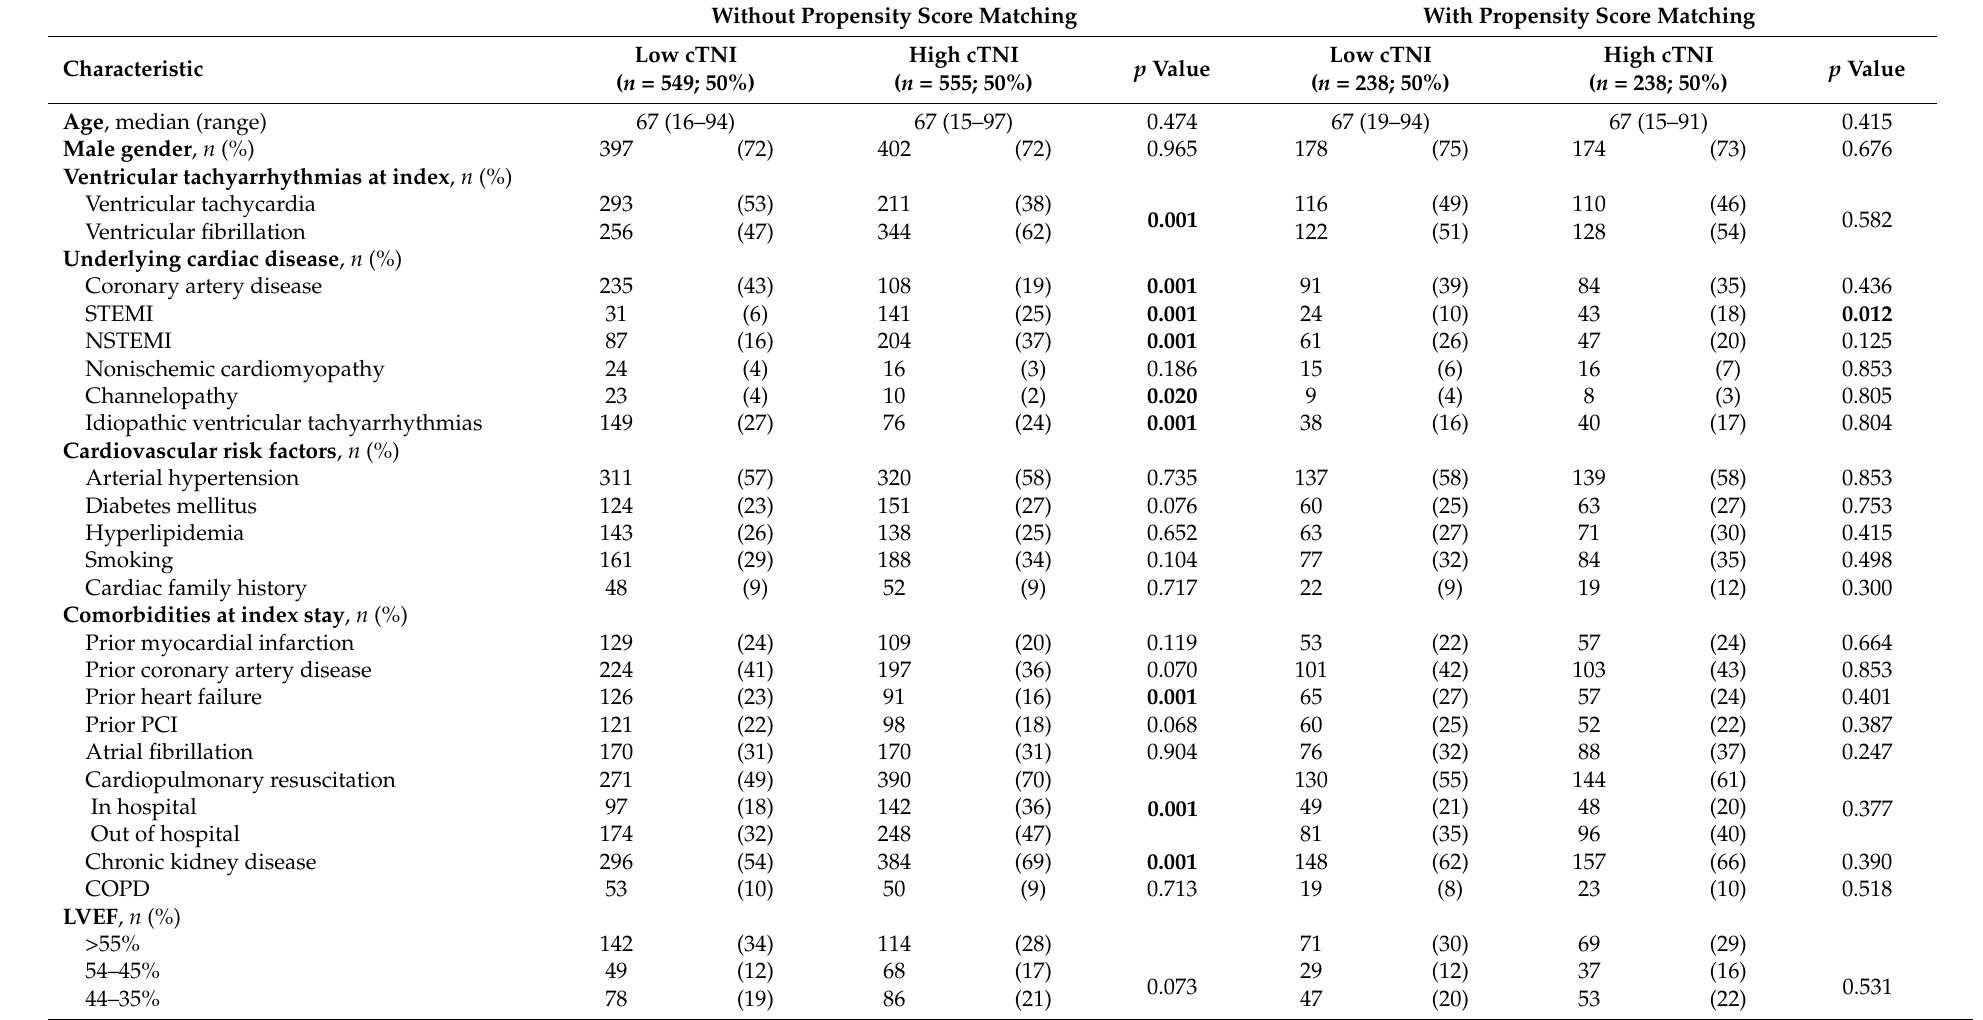
Table 1. Baseline characteristics before and after propensity score